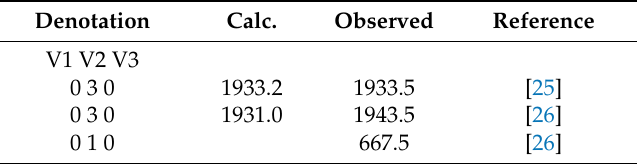
Table 1. Designation of the quantum states of the 1933 cm − 1 band in the CO 2 IR spectrum. Denotation